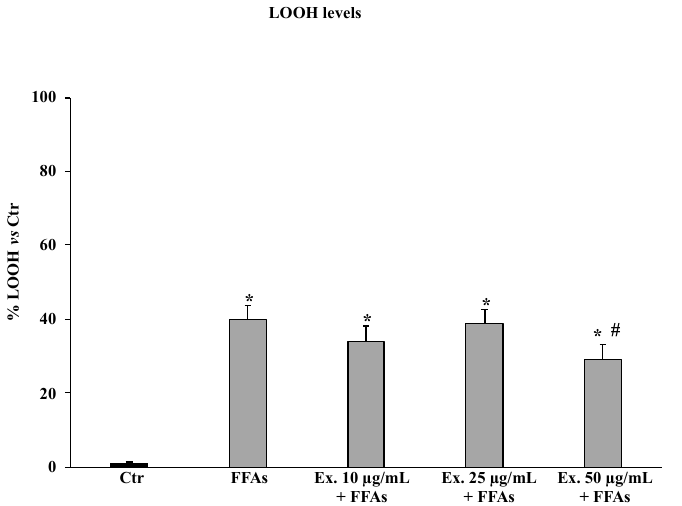
Figure 4. LOOH levels in HepG2 untreated cells (Ctr), HepG2 cells treated for 12 h with 1.5 mM FFAs, and HepG2 cells pre-treated with the extract (10–25–50 µg/mL) and exposed to FFAs 1. Results are expressed as percentage of lipid hydroperoxide levels vs. Ctr. Values are the mean ± S.D. of three independent experiments in triplicate. * Significant vs. untreated control cells: p < 0.001. # Significant vs. FFAs treated cells: p < 0.001.